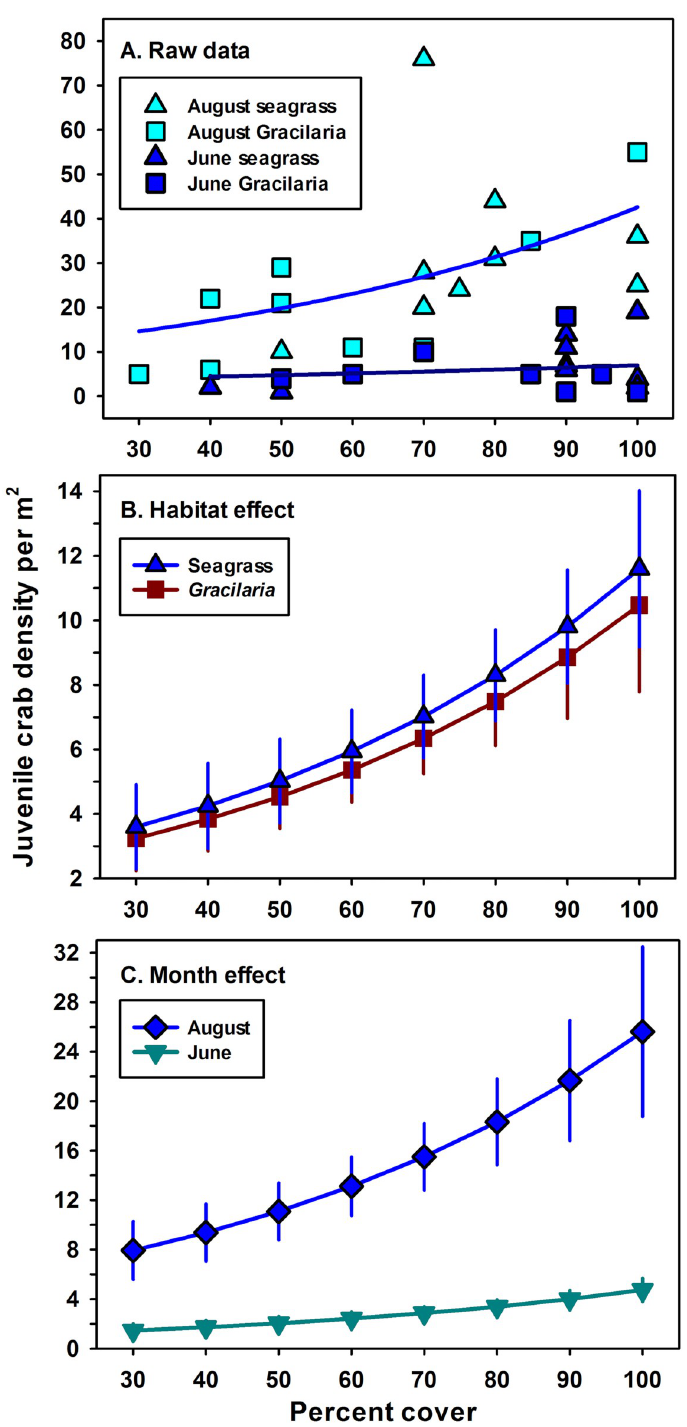
Fig 7. Juvenile crab density as a function of plant % cover, month, and habitat type using parameter estimates from model g 2 (Table 3). (A) Unadjusted crab densities with separate exponential fits to the raw data for August and June. Note that the curves do not account for the effect of habitat type. (B) Crab densities as a function of habitat type after accounting for the effect of month. (C) Crab densities as a function of month after accounting for the effect of habitat type. Error bars = ± 1 SE.